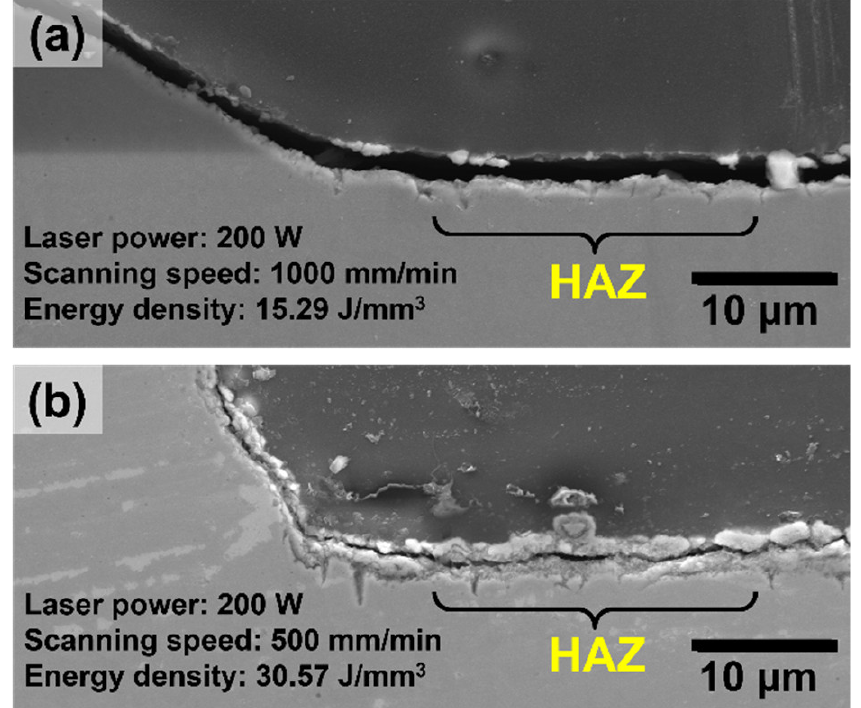
Figure 12. Cross-section secondary electron images of the corrosion morphology on the heat-affected zone of clads deposited using relatively low ( a ) and high ( b ) laser energy density. A much more severe corrosion attack can be seen for clad ( a ) than for clad ( b ).